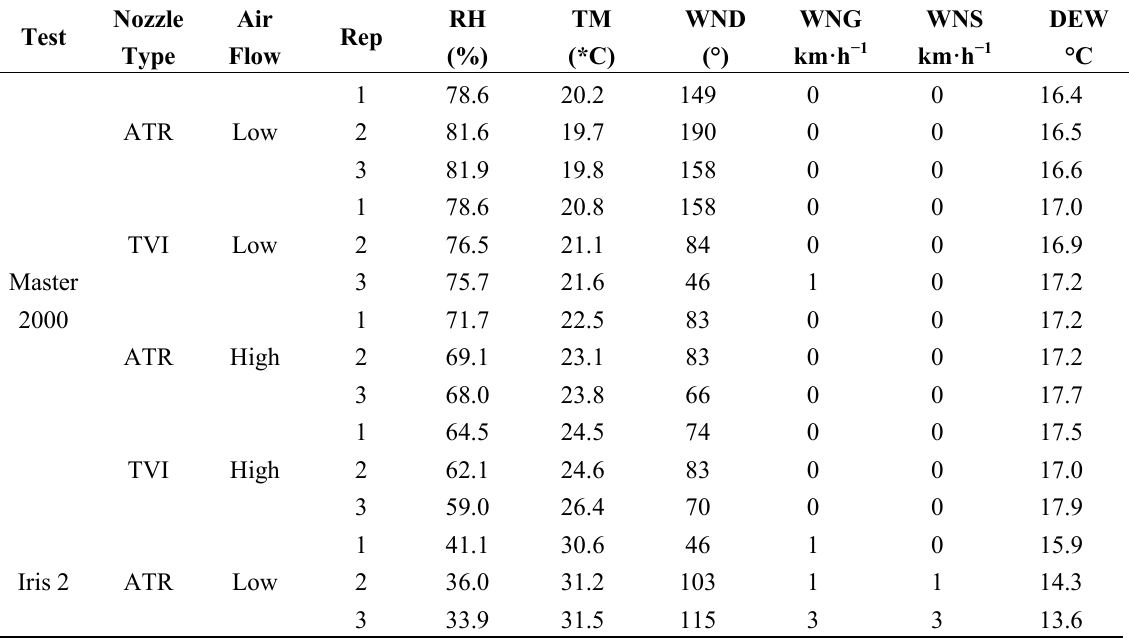
Table 2. Weather conditions recorded during the field tests. RH: relative humidity;